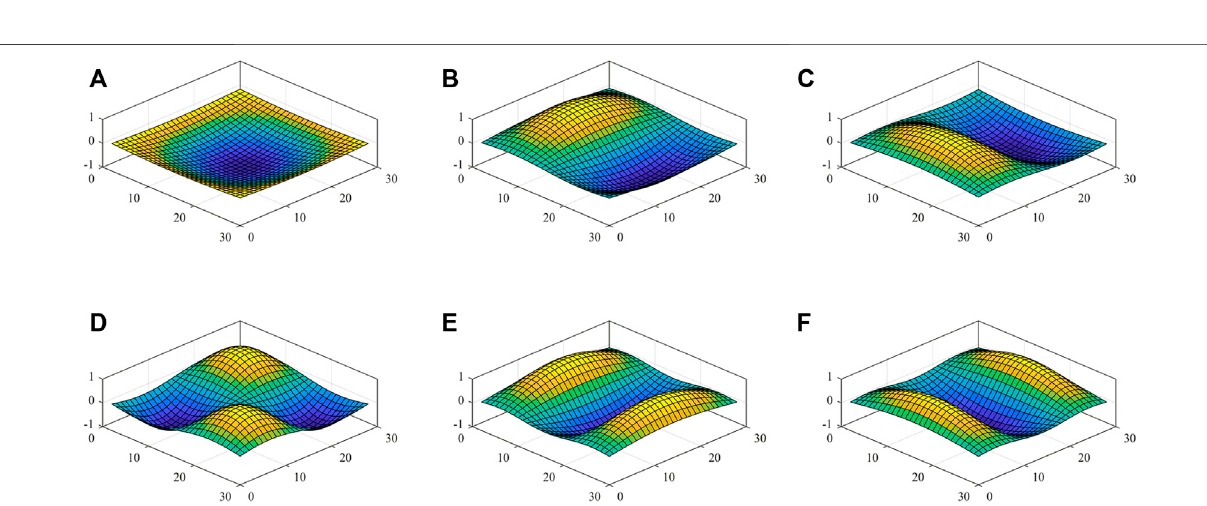
FIGURE 4 | First six modes of the piezoelectric-integrated FG plate (SSSS): (A) fi rst mode; (B) second mode; (C) third mode; (D) fourth mode; (E) fi fth mode; and (F) sixth mode.